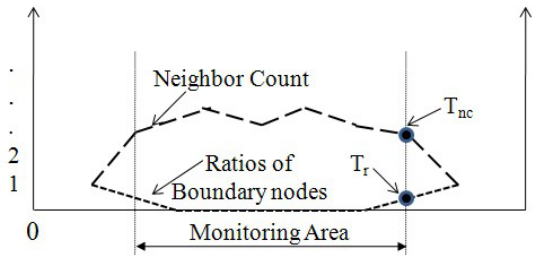
Figure 4. Concepts on the trends of the neighbor counts and the ratios of the boundary nodes and two